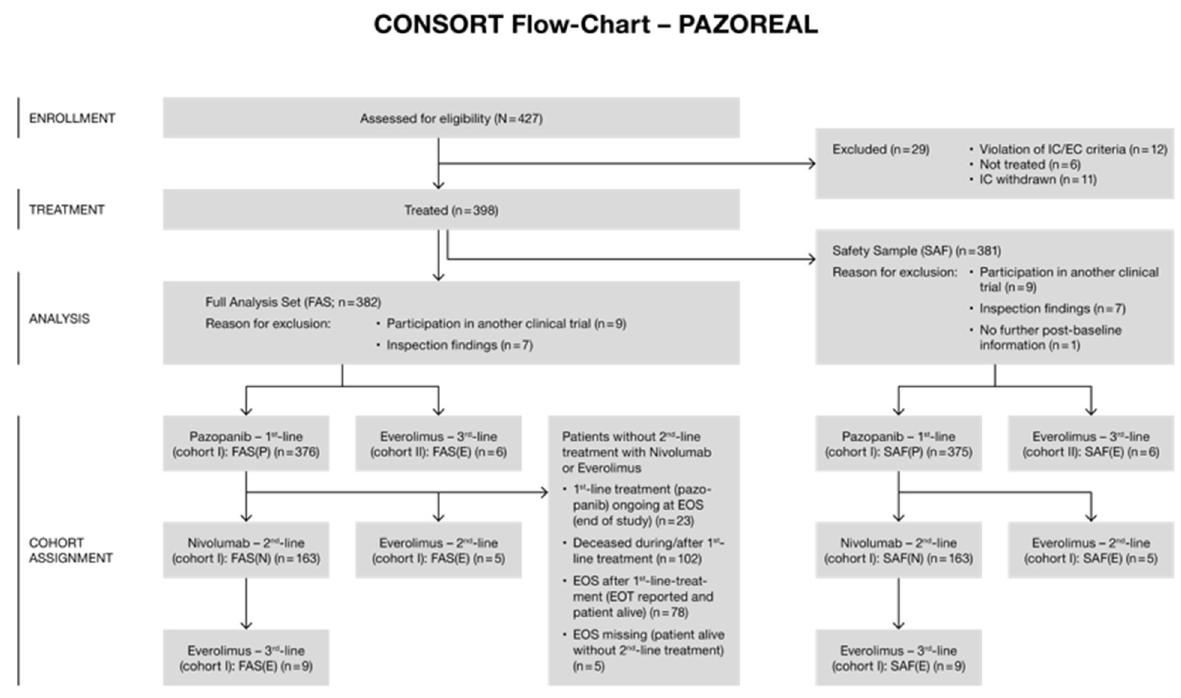
Figure 1. CONSORT flow chart for PAZOREAL with retrospective subset definition.